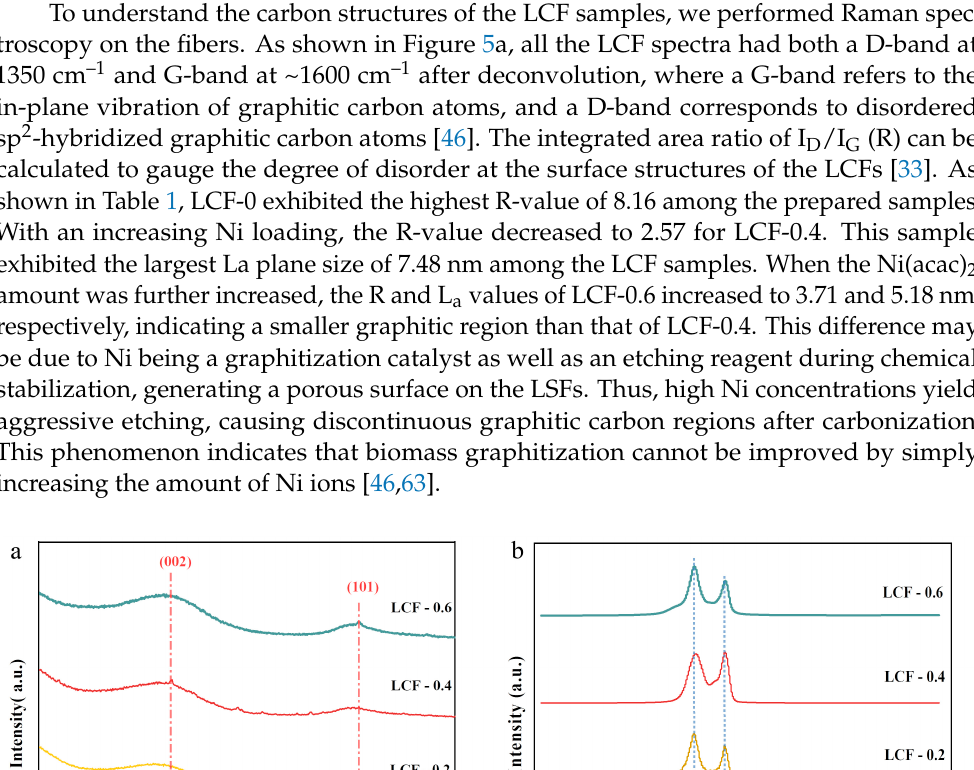
Table 2. Calculated Raman spectroscopy and XRD results for the